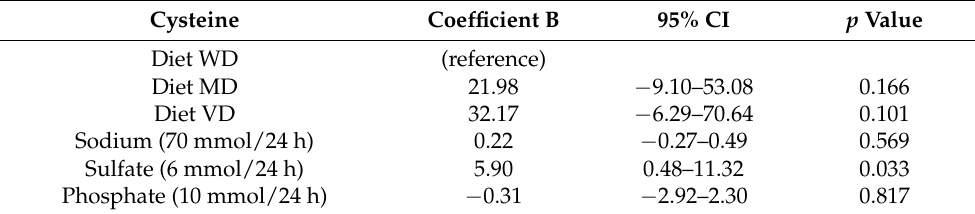
Table 4. Univariate associations of different diets and 24 h urinary parameters with urinary cys- teine